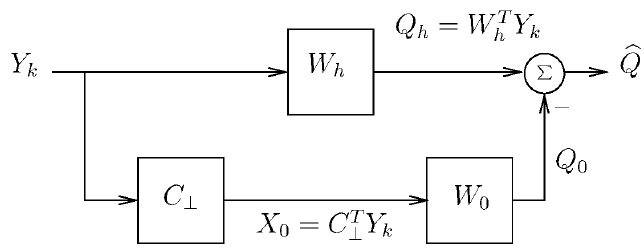
Figure 1. Structure of the generalized sidelobe